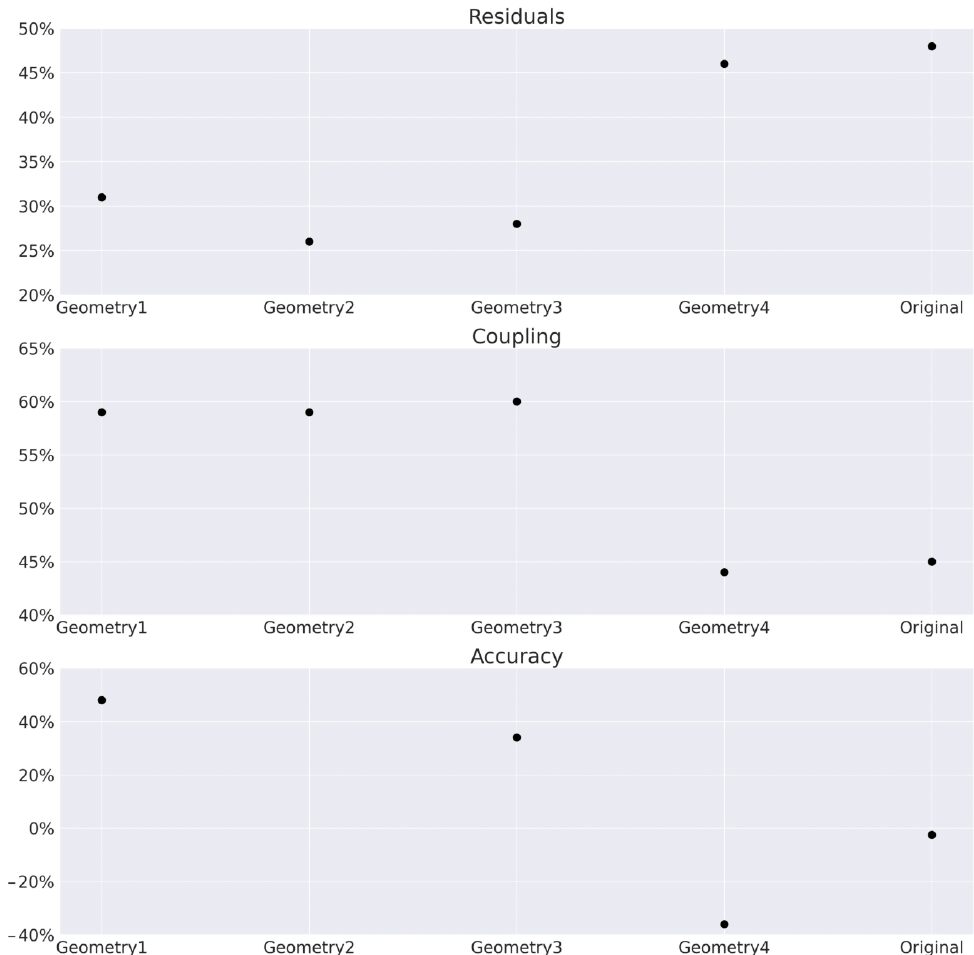
Figure 3. Relative reduction in number of needed iterations for satisfying convergence criteria for different numerical parameter